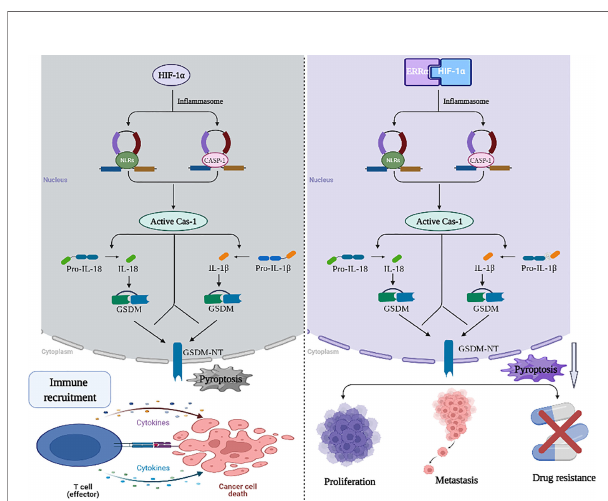
FIGURE 2 | Working model of the role of HIF-1 a /ERR a in pyroptosis resistance. HIF-1 a is a component of the molecular mechanism of pyroptosis mediated by NLRP3 in fl ammatory bodies, which can recruit immune cells to mediate the immune response. HIF-1 a /ERR a interaction promotes the adaptation of tumor cells to hypoxia and promotes cancer cell resistance to pyroptosis. These activities stimulate tumor proliferation, metastasis, and drug resistance. Images were made in BioRender